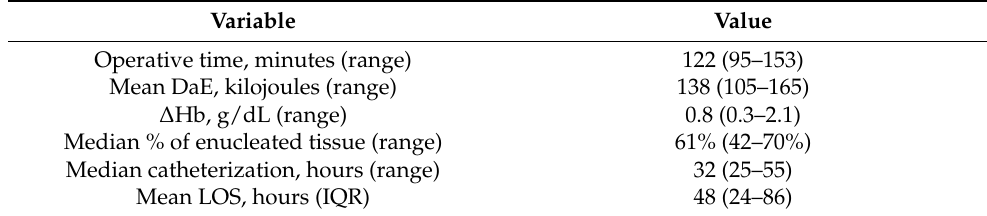
Table 2. Intra- and peri-operative data.